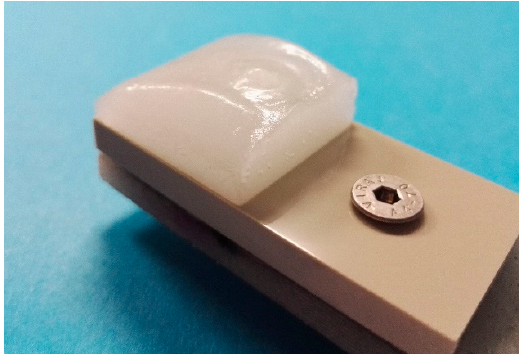
Figure 2. Mixed-glaze ice accreted in IWiT for CAT testing.